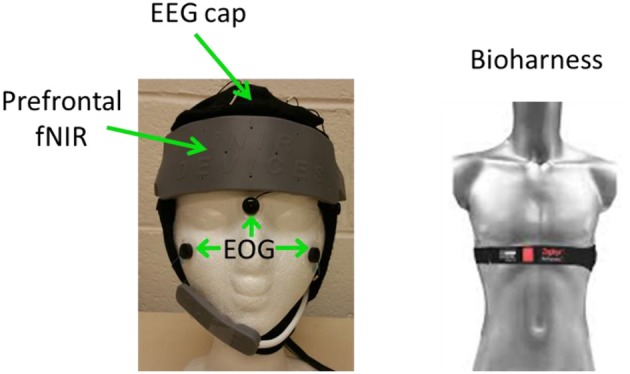
Recording setup.